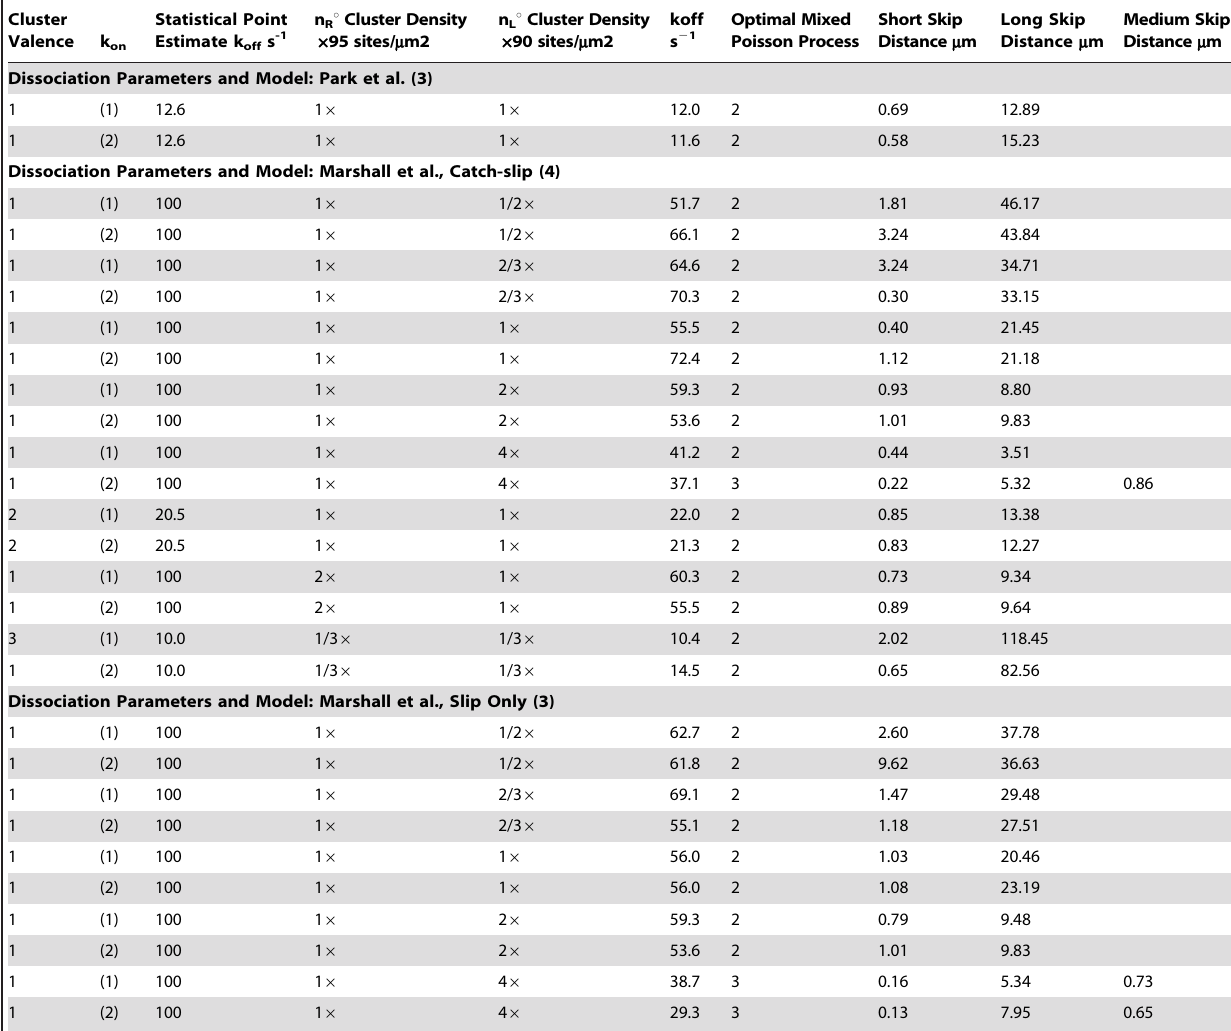
Table 2. Summary statistics for selected simulation conditions.